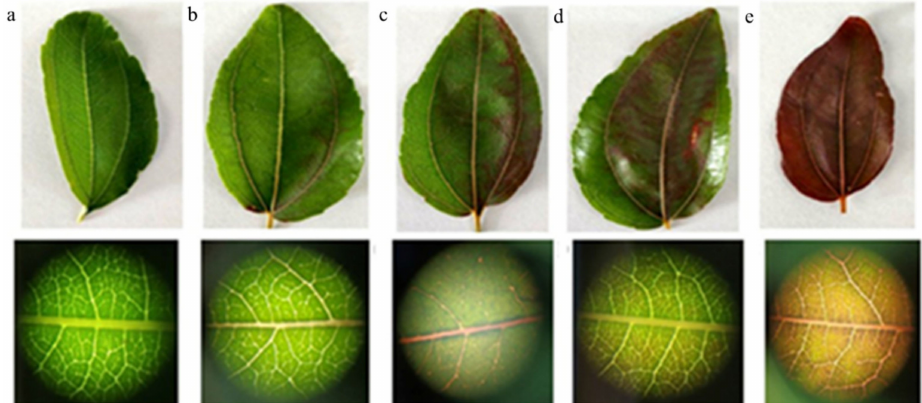
Figure 6. Distribution of dye in veins and lamina after different treatment time. ( a ) Untreated leaf; ( b ) 3 h and 10 min; ( c ) 3 h and 20 min; ( d ) 3 h and 30 min; ( e ) 3 h and 40 min.